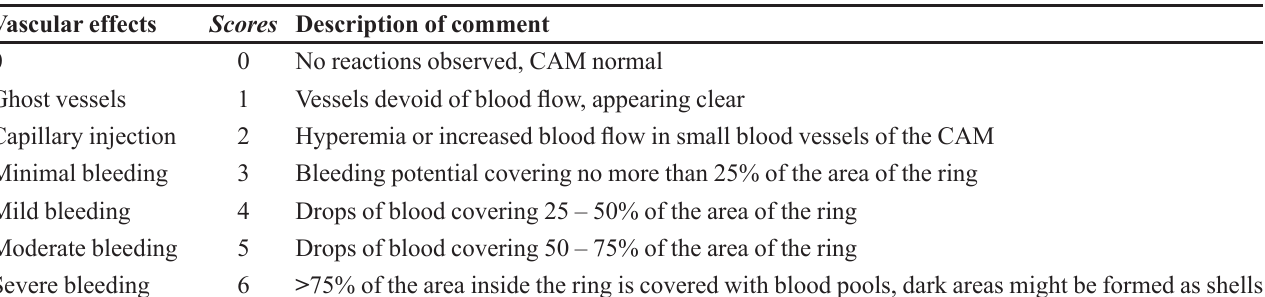
TABLE III - Scores comparing the vascular effects with the description of observation Vascular effects